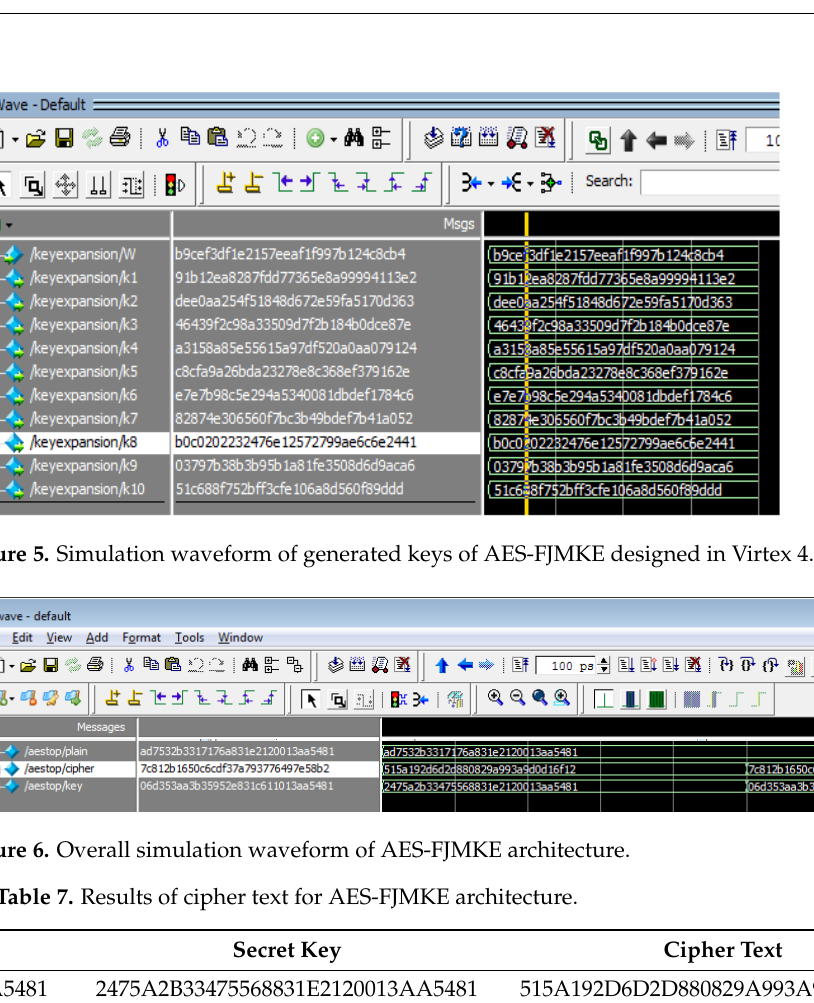
68 Table 6. Examination of delay and operating frequency for AES- FJMKE. FPGA Devices